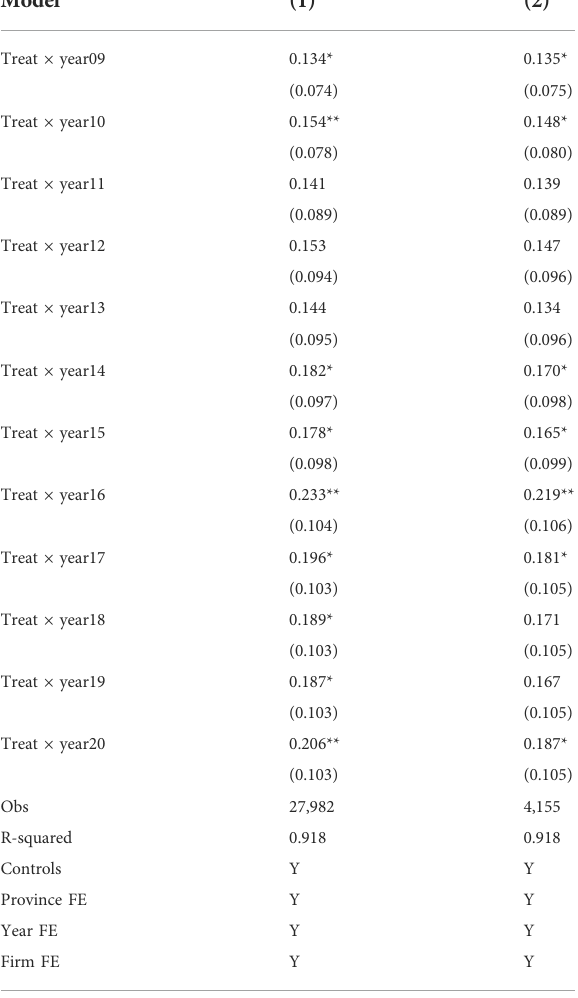
TABLE 4 Dynamic policy effect analysis results.